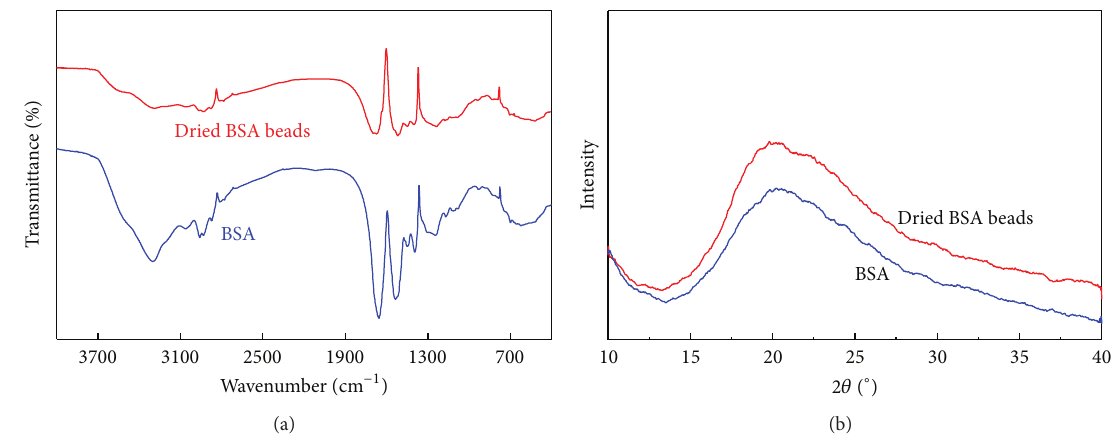
Figure 2: The FTIR spectra (a) and WAXRD curves (b) of BSA and dried cross-linked BSA beads.